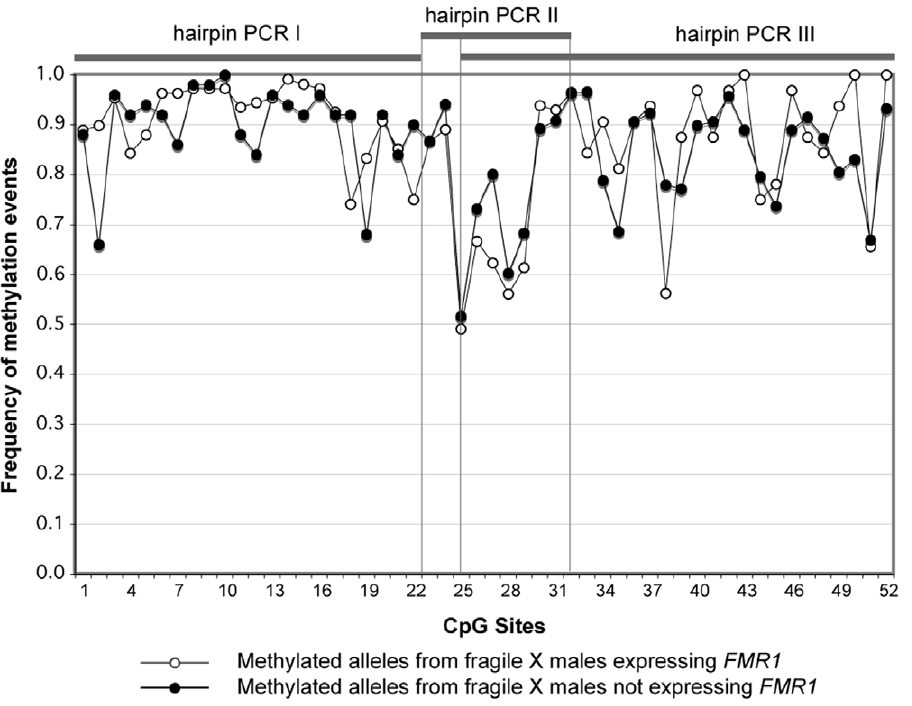
Figure 4. CpG site-specific methylation frequencies among hypermethylated epialleles. CpG site-specific methylation frequencies among hypermethylated epialleles as observed in samples from males with FXS who express (open circles), or do not express (filled circles) FMR1 . Data were pooled across hairpin assays I, II, and III. Vertical lines indicate the boundaries of the three different hairpins.